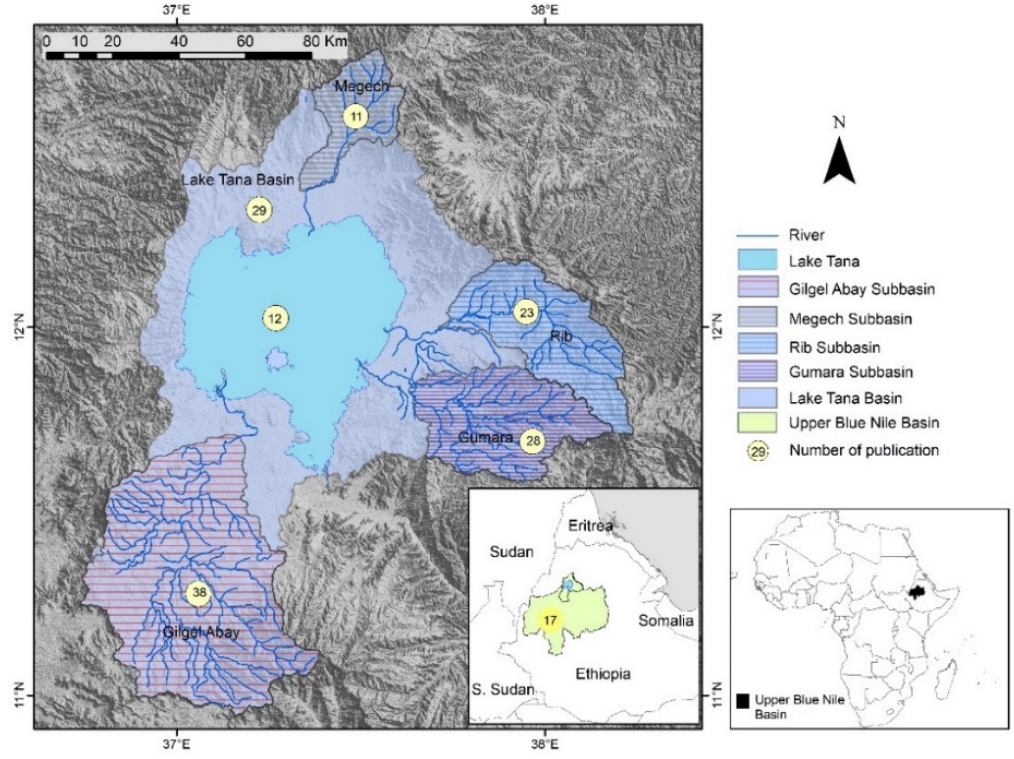
Figure 2. Number of publications in the domain of climate, hydrology and geomorphology of the Lake Tana Basin according to the spatial scope covered. One study can appear in more than one subbasin.